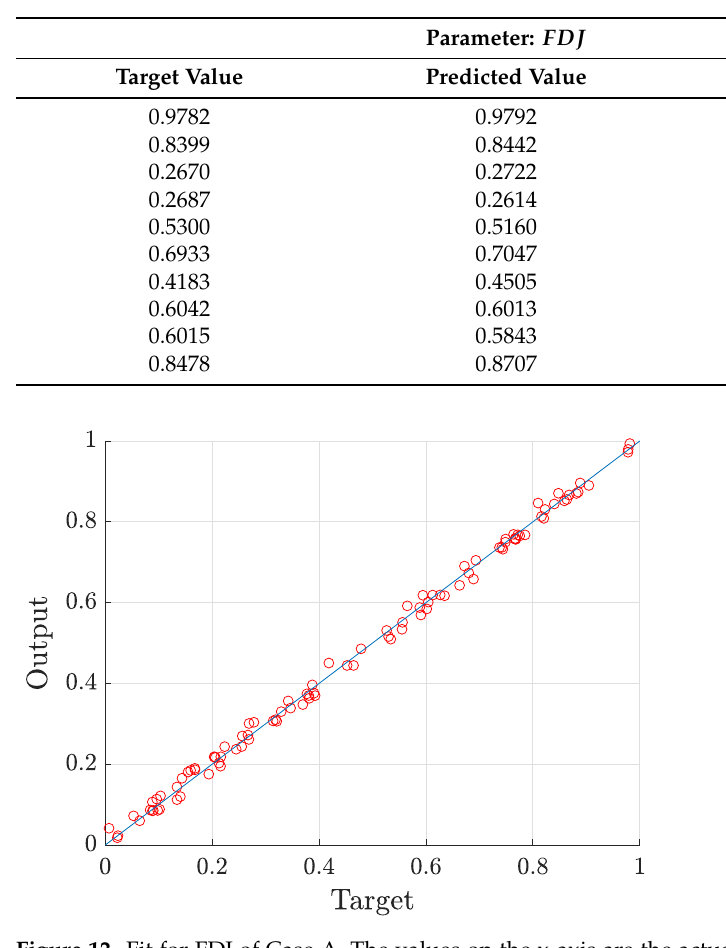
Figure 12. Fit for FDJ of Case A. The values on the x-axis are the actual values of the parameters (normalized between 0 and 1), while the values on the y-axis are those predicted by the network. Further discussions of the results of this case are reported in the next